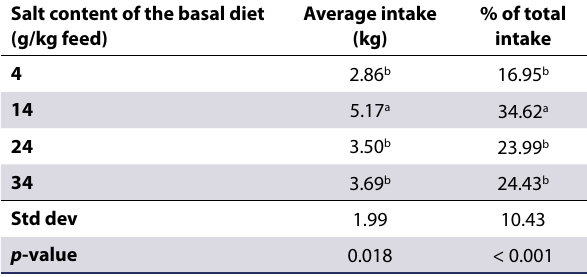
Table IV: Distribution (%) of salt preference as determined by feed intake of ostrich chicks 7–12 weeks of age during Trial 2, Experiment 1